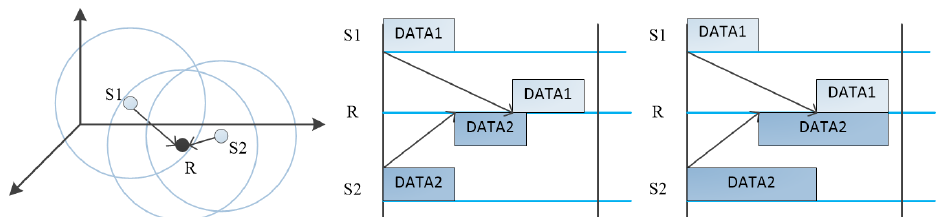
Figure 7. The effect of spatial-temporal uncertainty on packet length